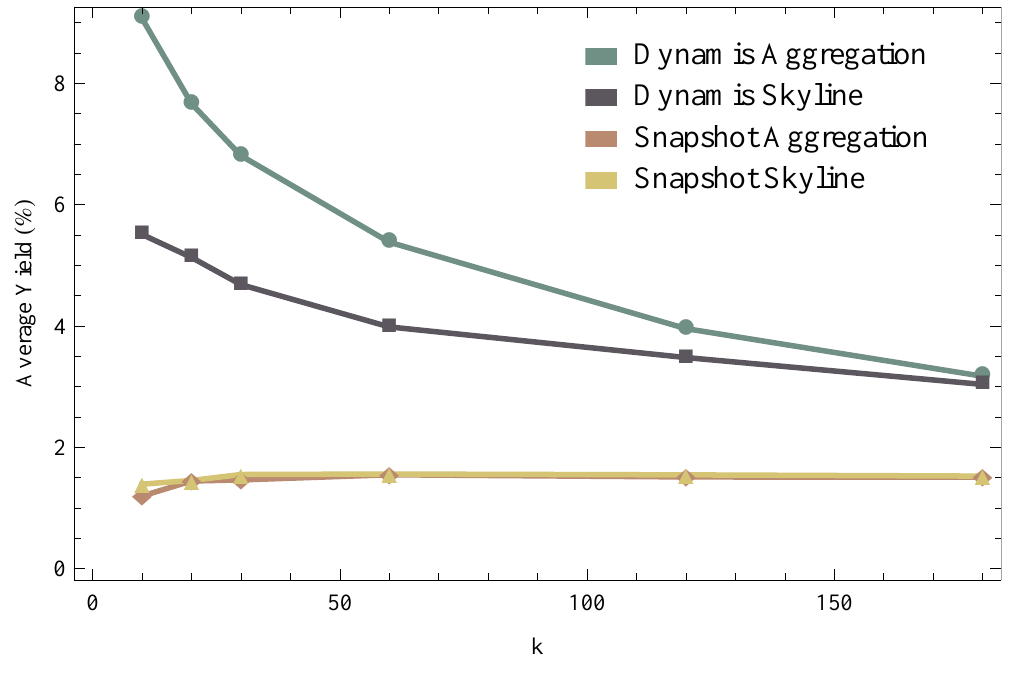
Figure 18. Average yield ( Y ) for a 20-trading day window ( w = 20) as we pick an increasing number of top k picks along the X -axis.